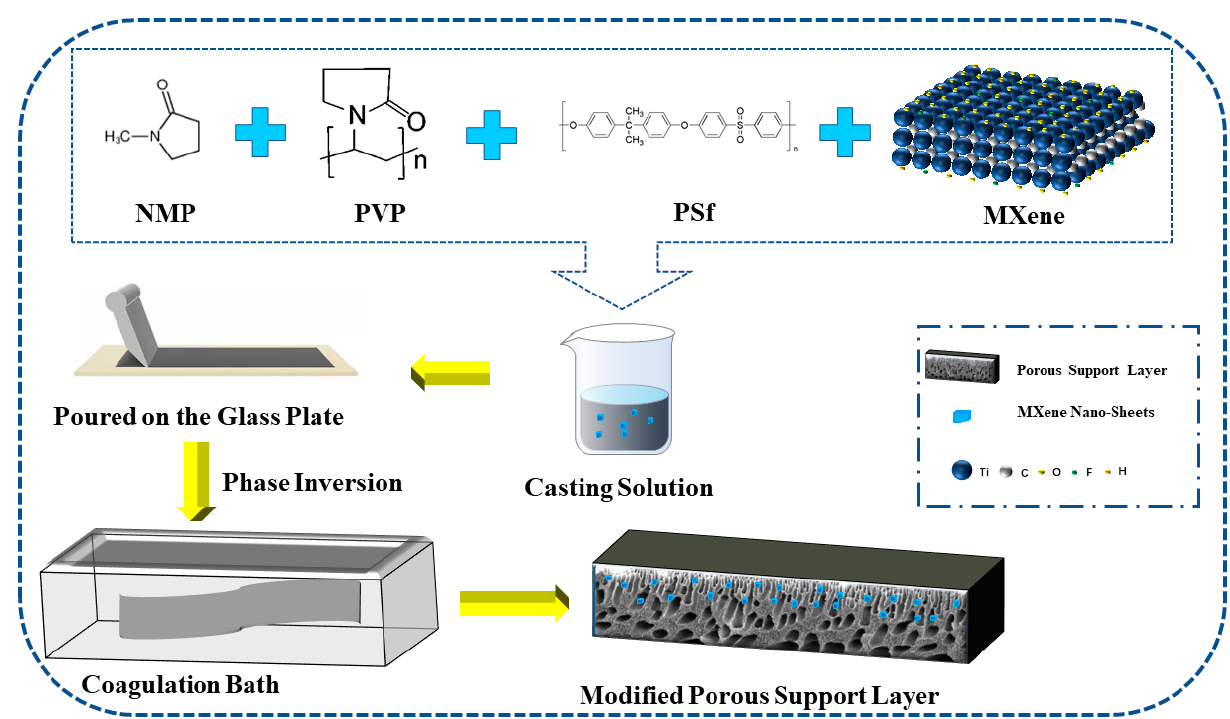
Figure 1. The porous support layer preparation by the phase inversion method.